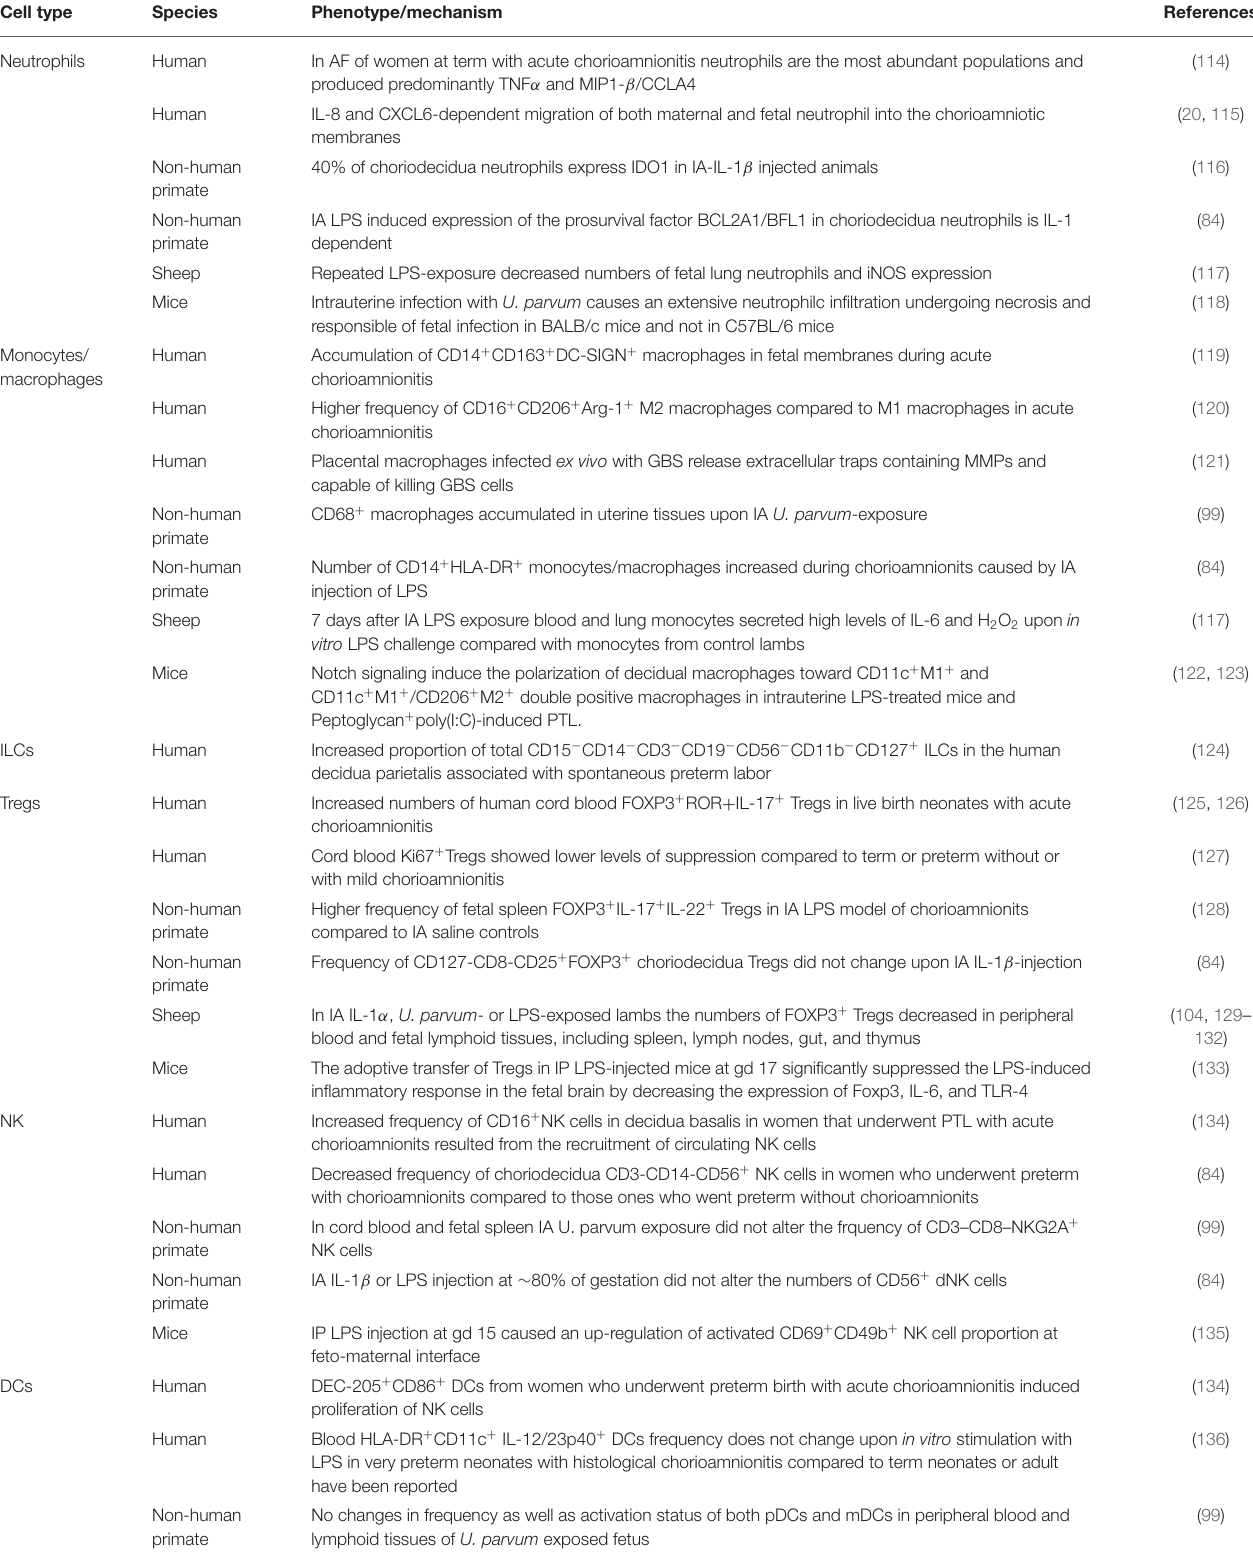
TABLE 2 | Immune and non-immune cells at the feto-maternal interface during